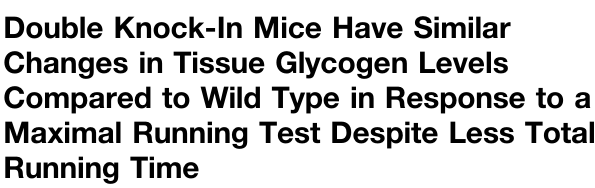
Frontiers in Physiology |